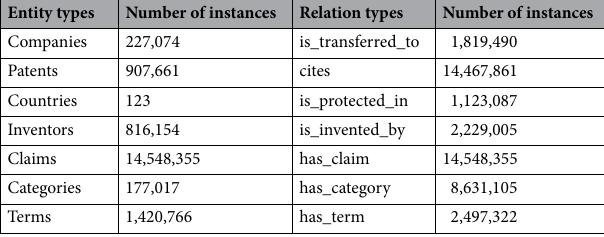
Table 3. Statistics of the knowledge